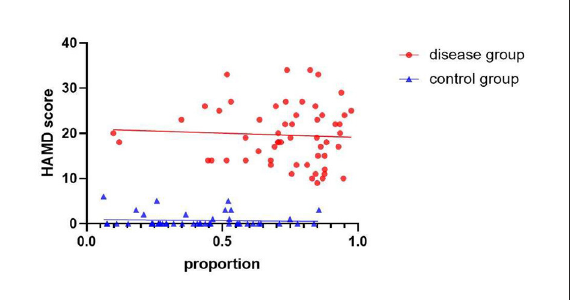
FIGURE3 The comparison between two models. Depression classifier: traditional hand-engineered features model. DepAudioNet: deep learning-based Model. By observing the difference in sensitivity, specificity and AUC between the two models, the performance of pre-trained model is significantly improved can be seen.